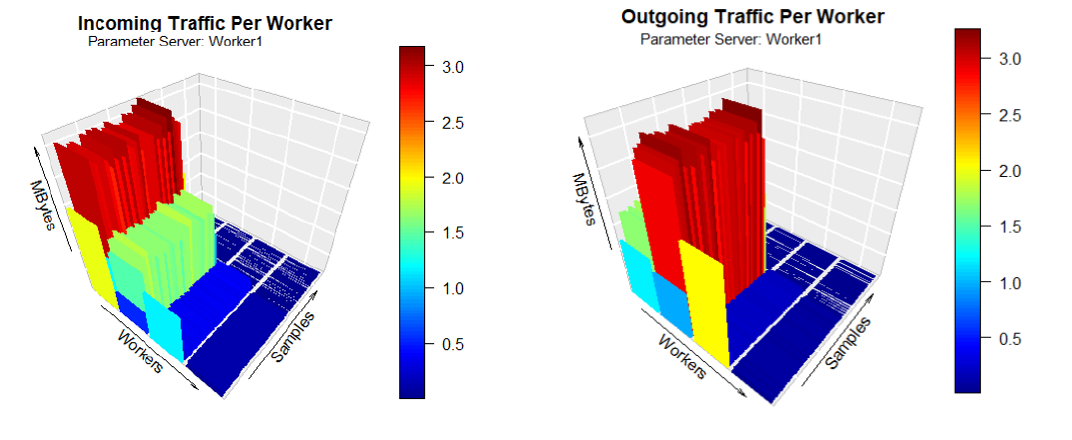
Figure 12. Communication traffic per worker for the ’optimized’